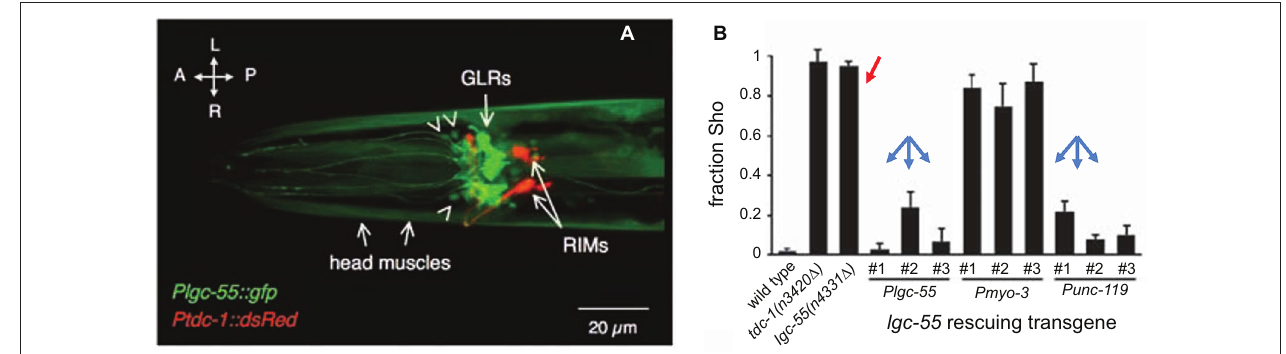
in the lgc-55 gene (or in the tdc-1 gene, encoding tyrosine decarboxylase, an enzyme that converts L-tyrosine to tyramine) do not suppress foraging movements when crawling backward (Sho phenotype; red arrow). Re-expression of the LGC-55 driven by either the lgc-55 or unc-119 (pan-neural) promoters (blue arrows), but not by myo-3 (muscle) promoter, rescues the behavioral phenotype, indicating that glia or neurons are responsible for the behavior. Adapted from Ringstad et al.